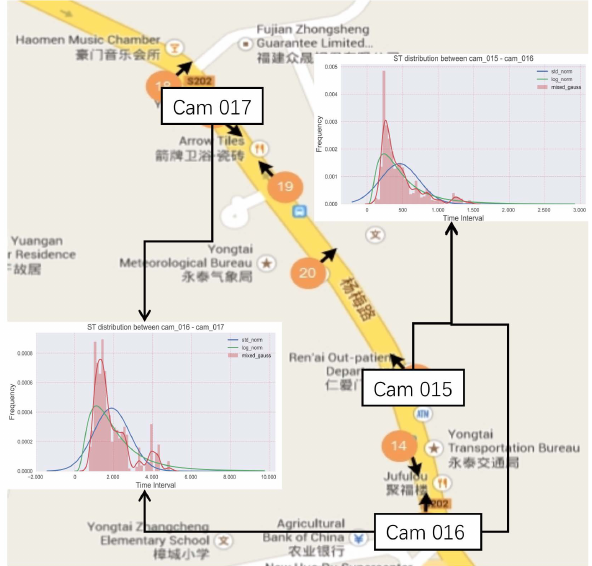
Figure 10. Spatio-temporal statistics for camera pairs.